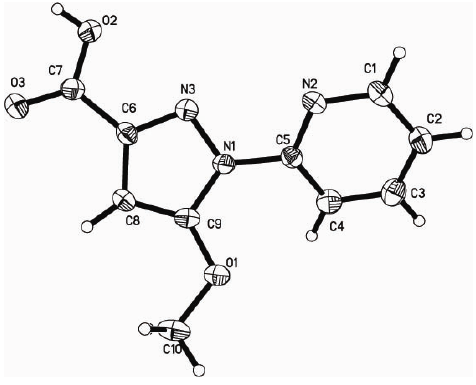
Figure 2. ( a ) UV-vis spectra of K